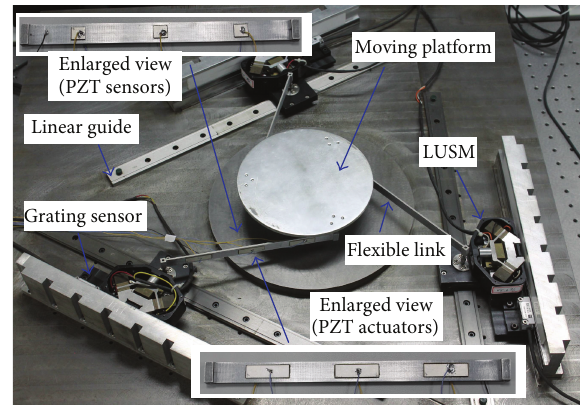
Figure 7: Arrangement of the PZT transducers.